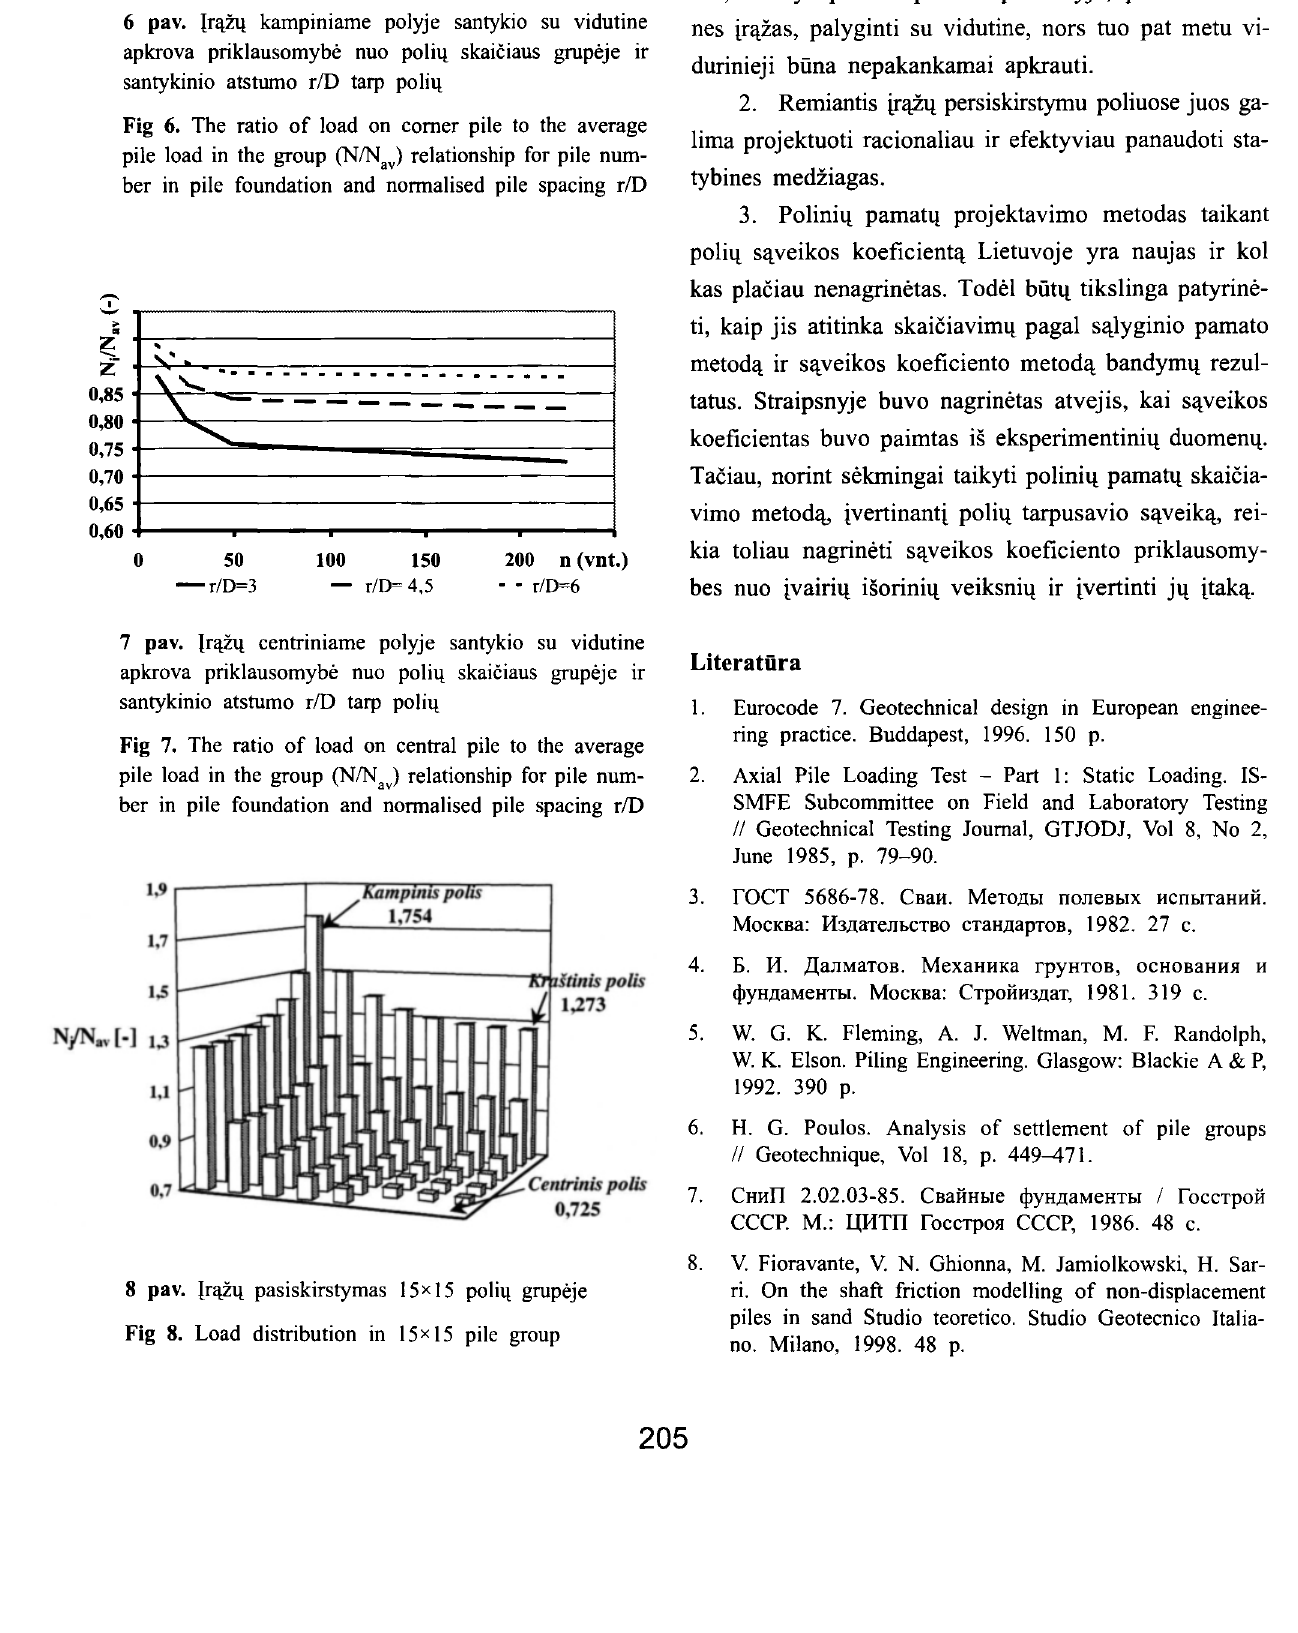
Fig 8. Load distribution in 15 xI 5 pile group